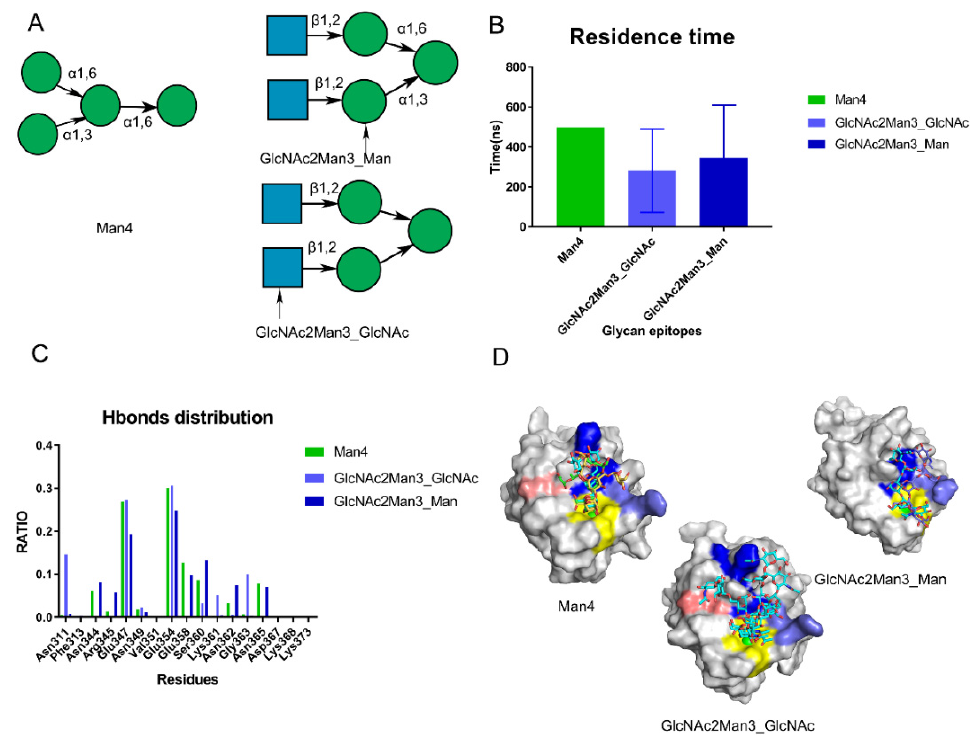
Figure 5. Validation of the proposed sites by performing MD simulations of crystal structures (PDB:1SL4,1K9I). ( A ) the crystal structures on the Man4 (PDB: 1SL4) and GlcNAc2Man3 (PDB: 1K9I). The monosaccharide binding with DC-SIGN’s Ca 2+ ions in GlcNAc2Man3 crystal structure is indicated by the arrow. ( B ) Residence time along the triple trajectories. ( C ) Hydrogen bond distribution RATIO of these crystal structures along the trajectories. ( D ) Conformations of Man4, GlcNAc2Man3_GlcNAc, GlcNAc2Man3_Man located at different sites along the trajectories. Core site is shown by yellow, Rift site is shown in blue; Valley is shown in purple-blue; Lys368 in pink.